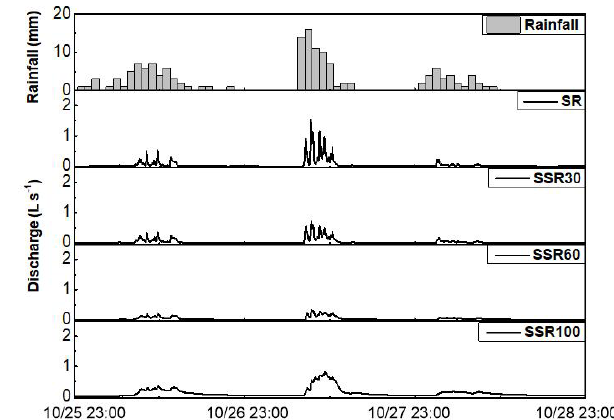
Figure 2. Hydrographs of the separate runoff in the 2016 autumn rainfall